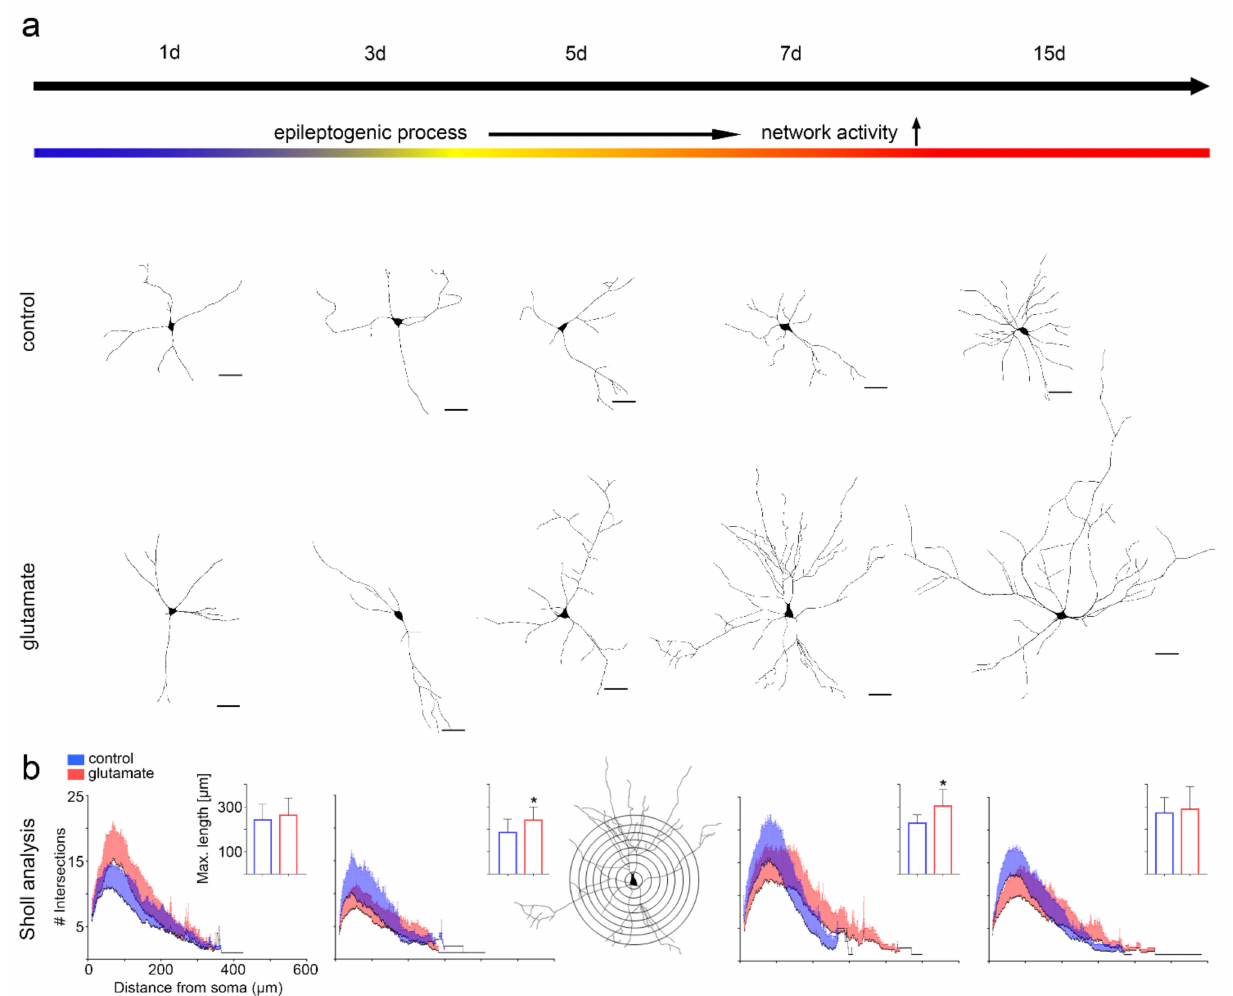
Figure 2. Neuronal morphology in epileptogenesis in vitro. ( a ) Representative images of individual neurons at different time points and sham or glutamate treatment. ( b ) Sholl analysis of 30 captured neurons per time point and treatment. The number of neurite branches or intersections was plotted against the distance from the soma. Schematic of Sholl analysis shown in the middle. Asterisks (*) indicate significance.